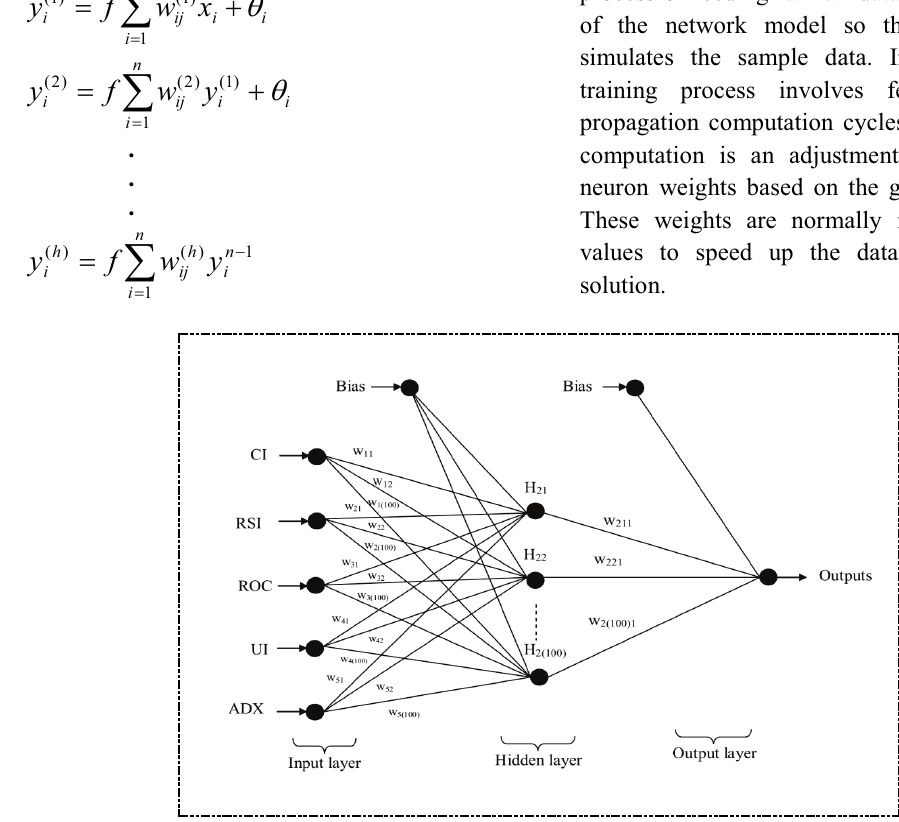
Fig.4. Neural network model of proposed